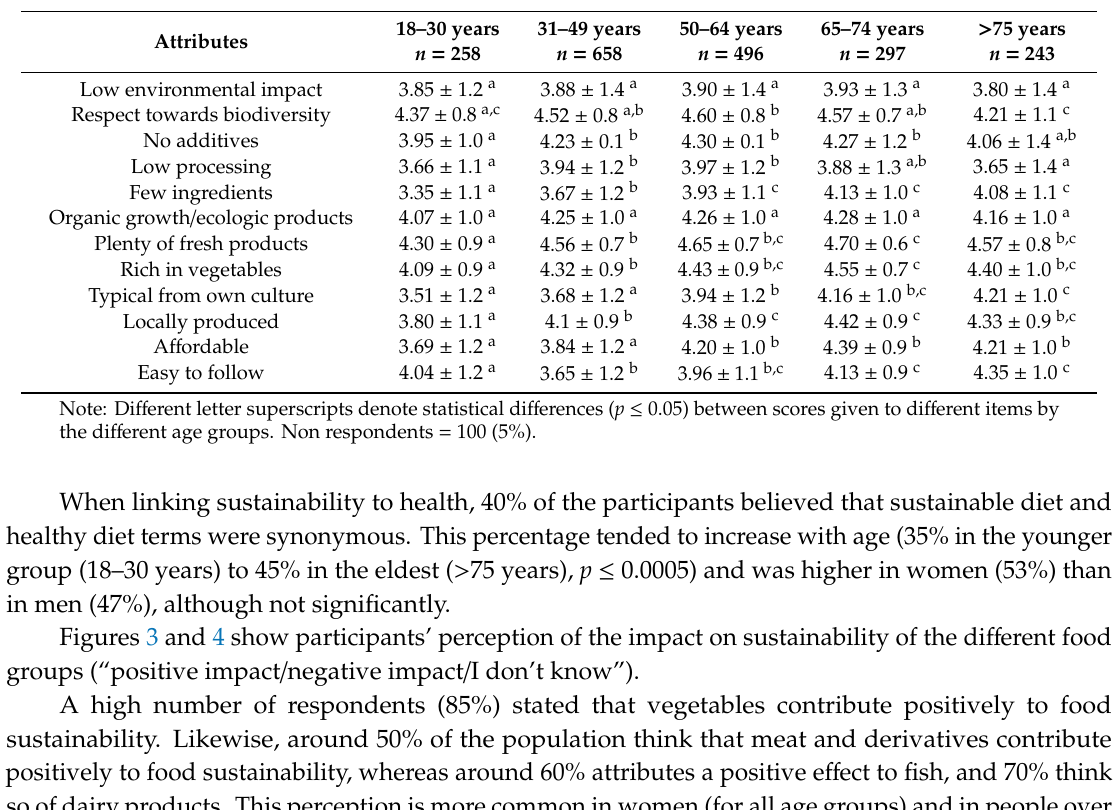
Table 3. Perceived attributes that define a sustainable diet, in a scale 1–5 (1 = not important at all to 5 = very important) in Spanish adult population, by age